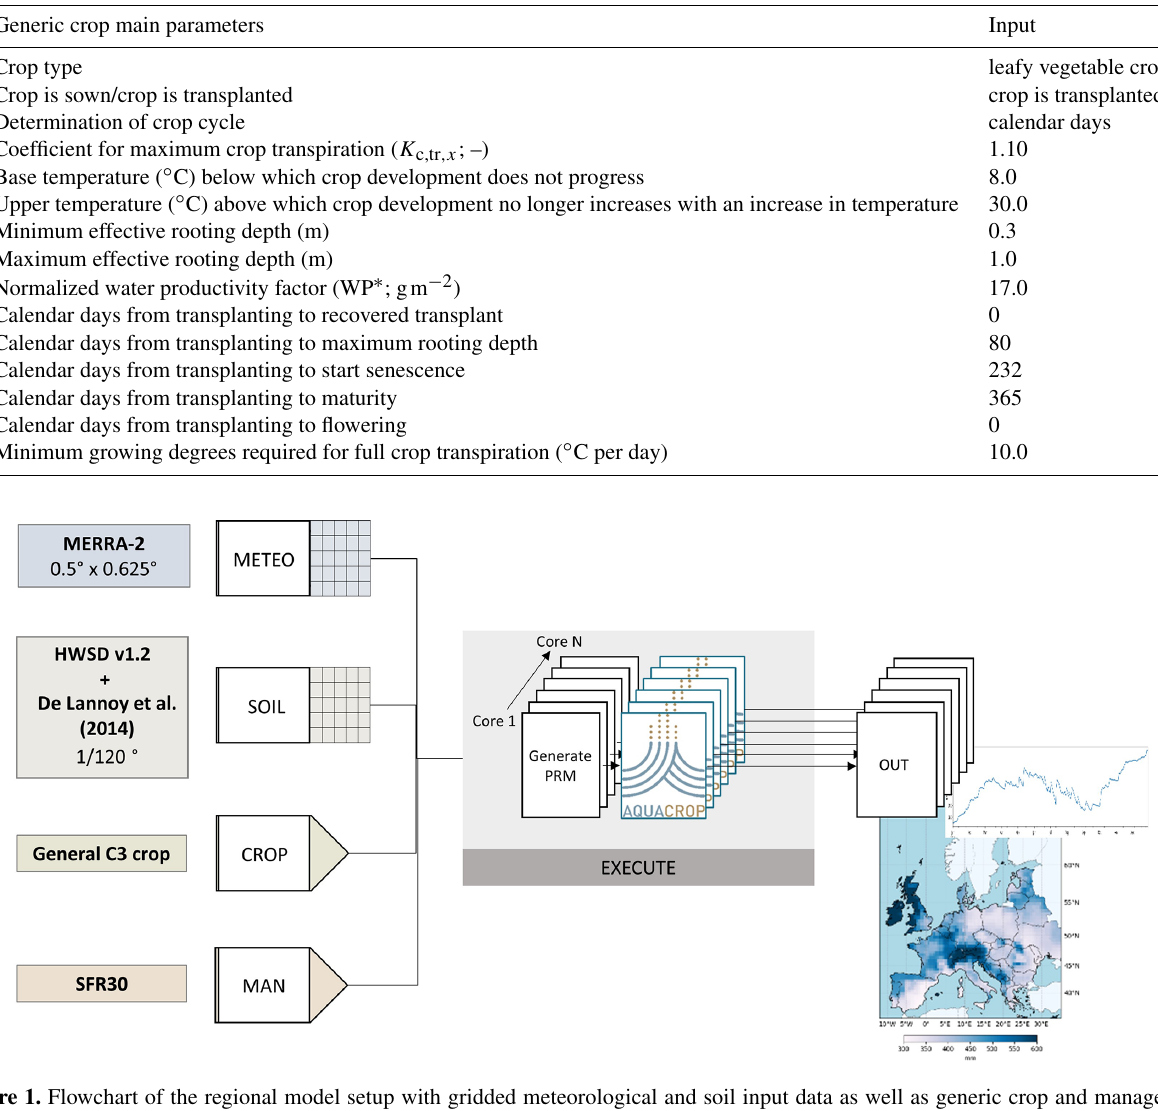
Table 1. Main crop parameters of the generic crop to simulate biomass over Europe.